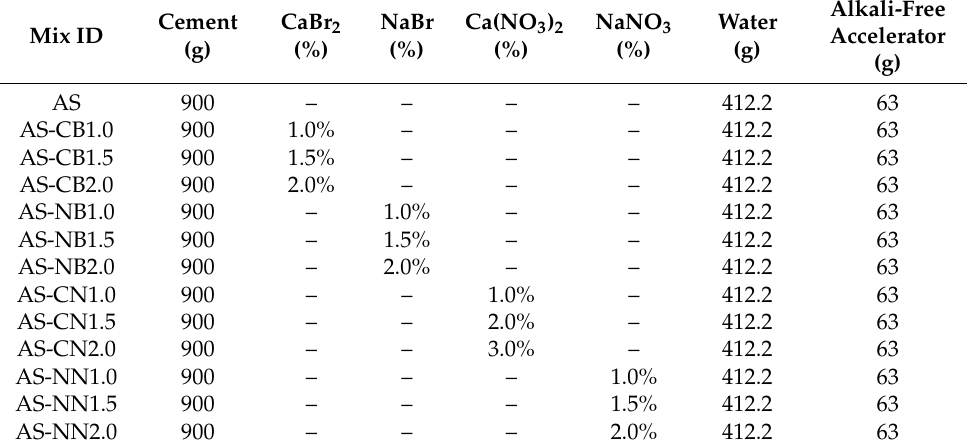
Table 4. Mixing design